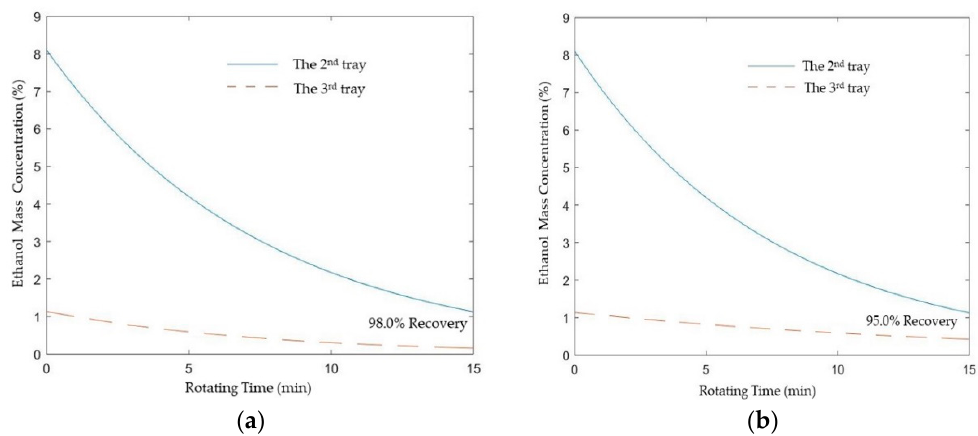
Figure 9. The decline curve of ethanol concentration with rotating time in di ff erent column tray. ( a ) The same steam flow rate in 2nd and 3rd tray; ( b ) The 3rd tray steam flow rate is half of the 2nd tray. The final design factors of the CSSD column were determined as optimization and calculation results. The diameter of the column is 4 m, and one heating tray and two extracting trays were set along the shaft. The e ff ective height of each tray was 400 mm. The steam distributor was equipped